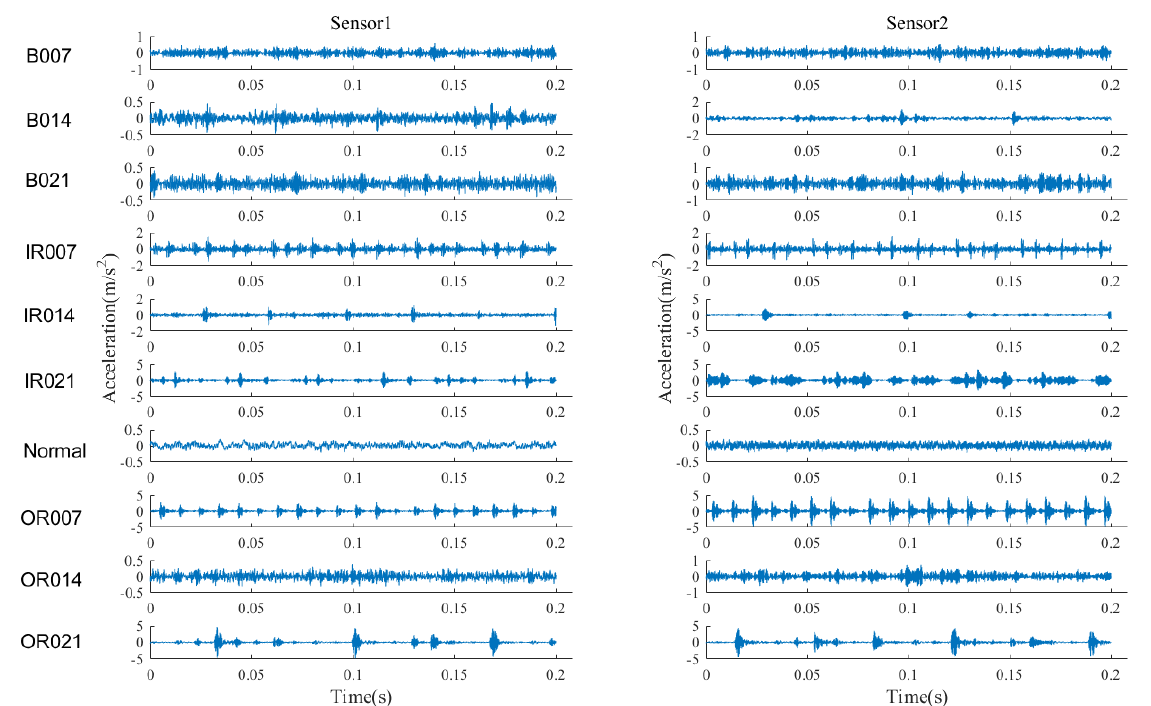
Figure 6. Time-domain waveforms of raw vibration signals collected by two